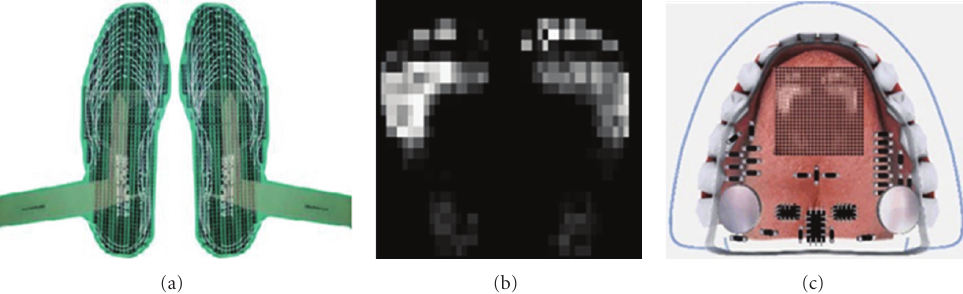
Figure 5: (a) Insole pressure sensory arrays (F-Scan); (b) visual representation of ground reaction force; (c) Mina representation of contact forces on Wicab BrainPort IOD.